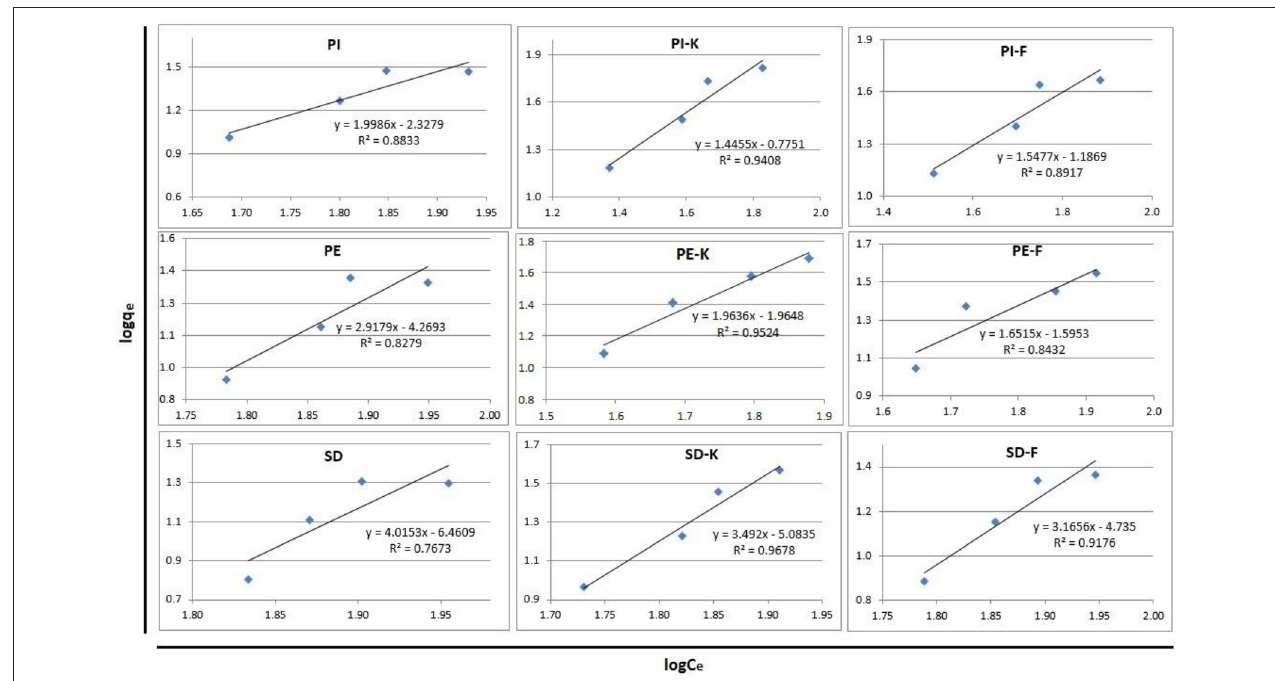
FIGURE 7 | Freundlich isotherms for phenols adsorption on biochars PI, PE, SD, and modified biochars PI-K, PE-K, SD-K or PI-F, PE-F, SD-F.